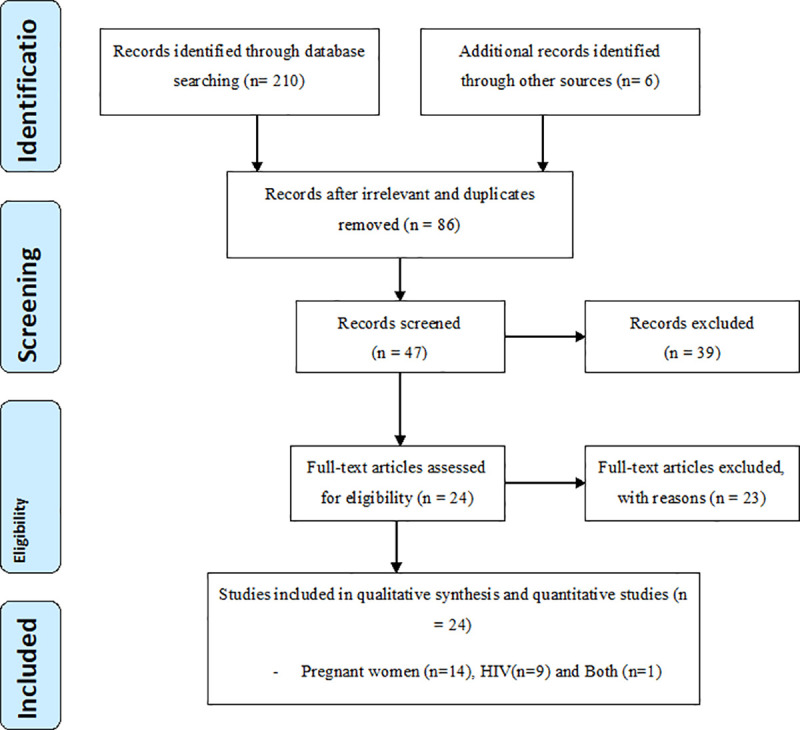
PRISMA flow diagram used for study searching process.